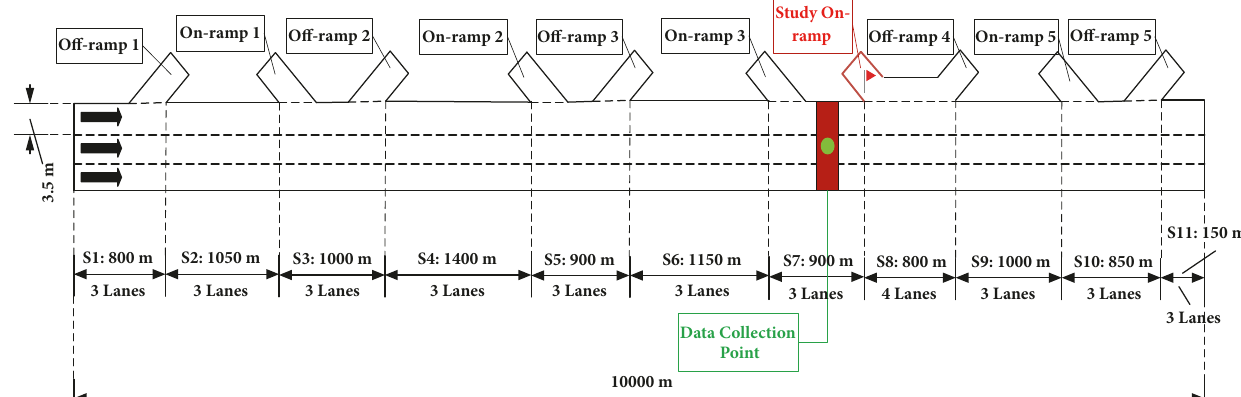
Figure 1: The sketch map of research area.